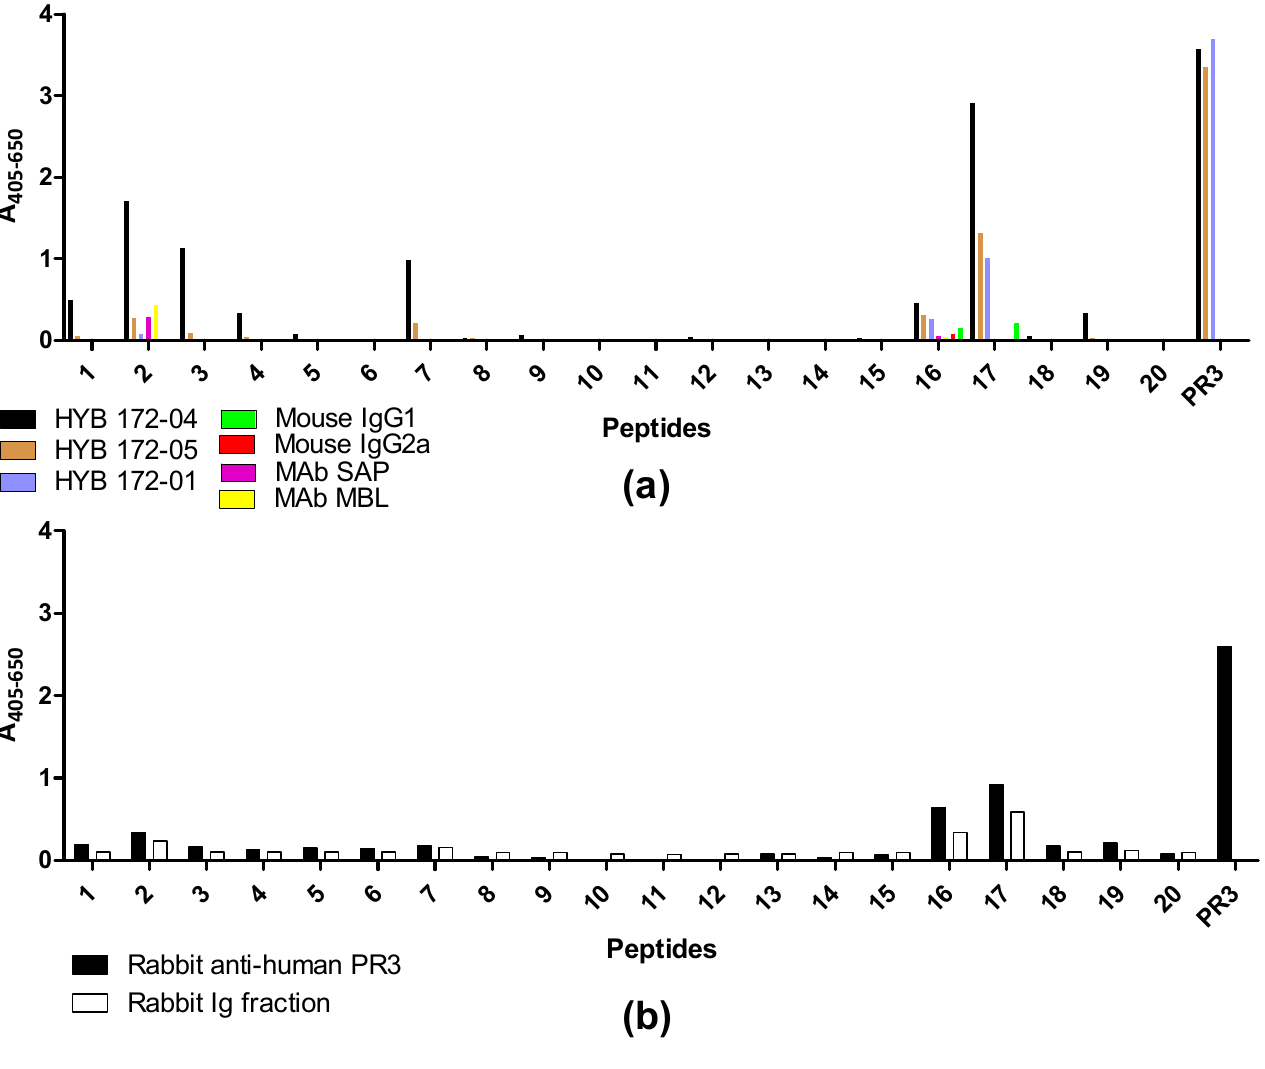
Figure 9. Epitope mapping of PR3 using overlapping peptides coupled to CovaLink-NH microtitre plates and MAb PR3 HYB 172-01, 172-04 and 172-05 analysed by ELISA. PR3 and wells without peptides were used as positive and negative controls, respectively. All wells were corrected for non-specific binding by subtracting reactivity from non-coated wells. ( a ) HYB 172-01, HYB 172-04, HYB 172-05, mouse IgG1 and IgG2a control binding. SAP MAb (IgG1) and MBL MAb (IgG1) binding. SAP Mab and MBL MAb were adjusted to the same concentration as the three PR3 HYBs and used as negative controls. ( b ) Rabbit anti-human PR3 and rabbit IgG binding.